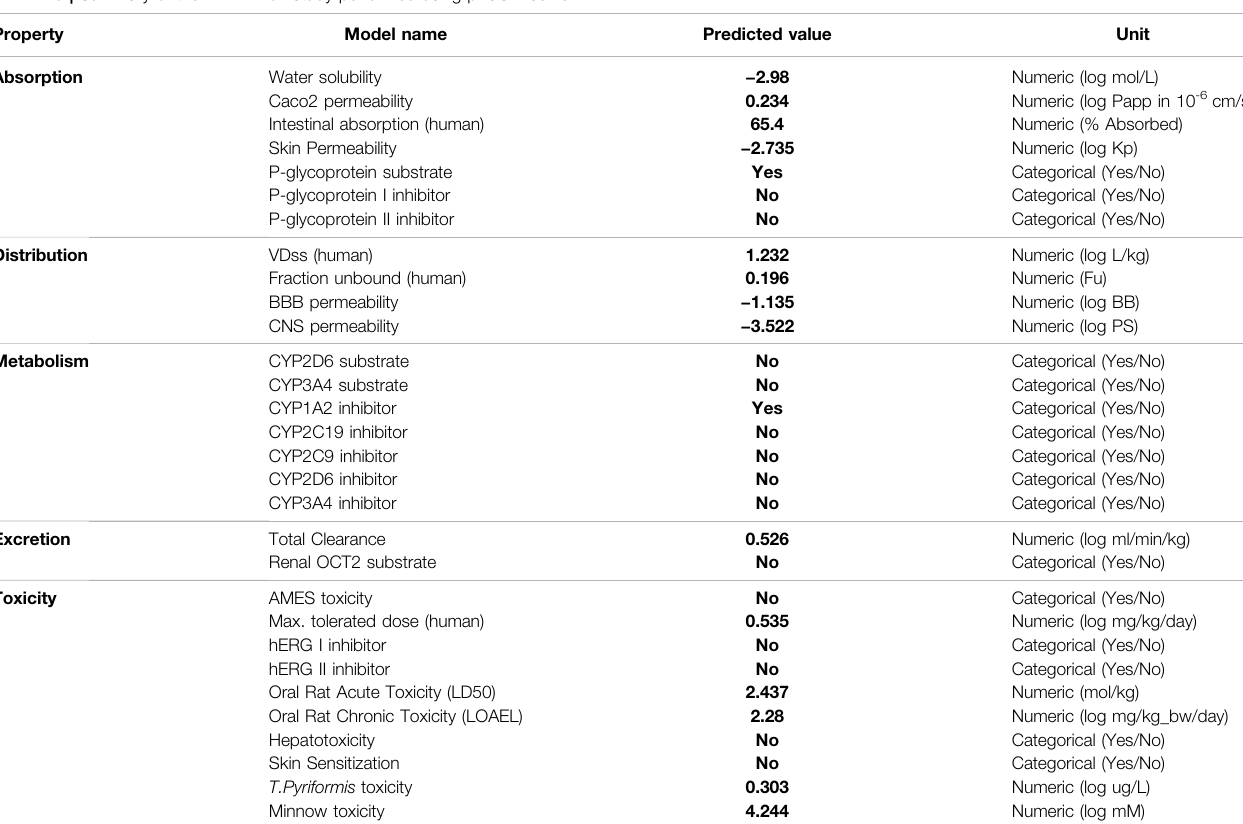
TABLE 3 | Summary of the ADME-Tox study performed using pkCSM server.